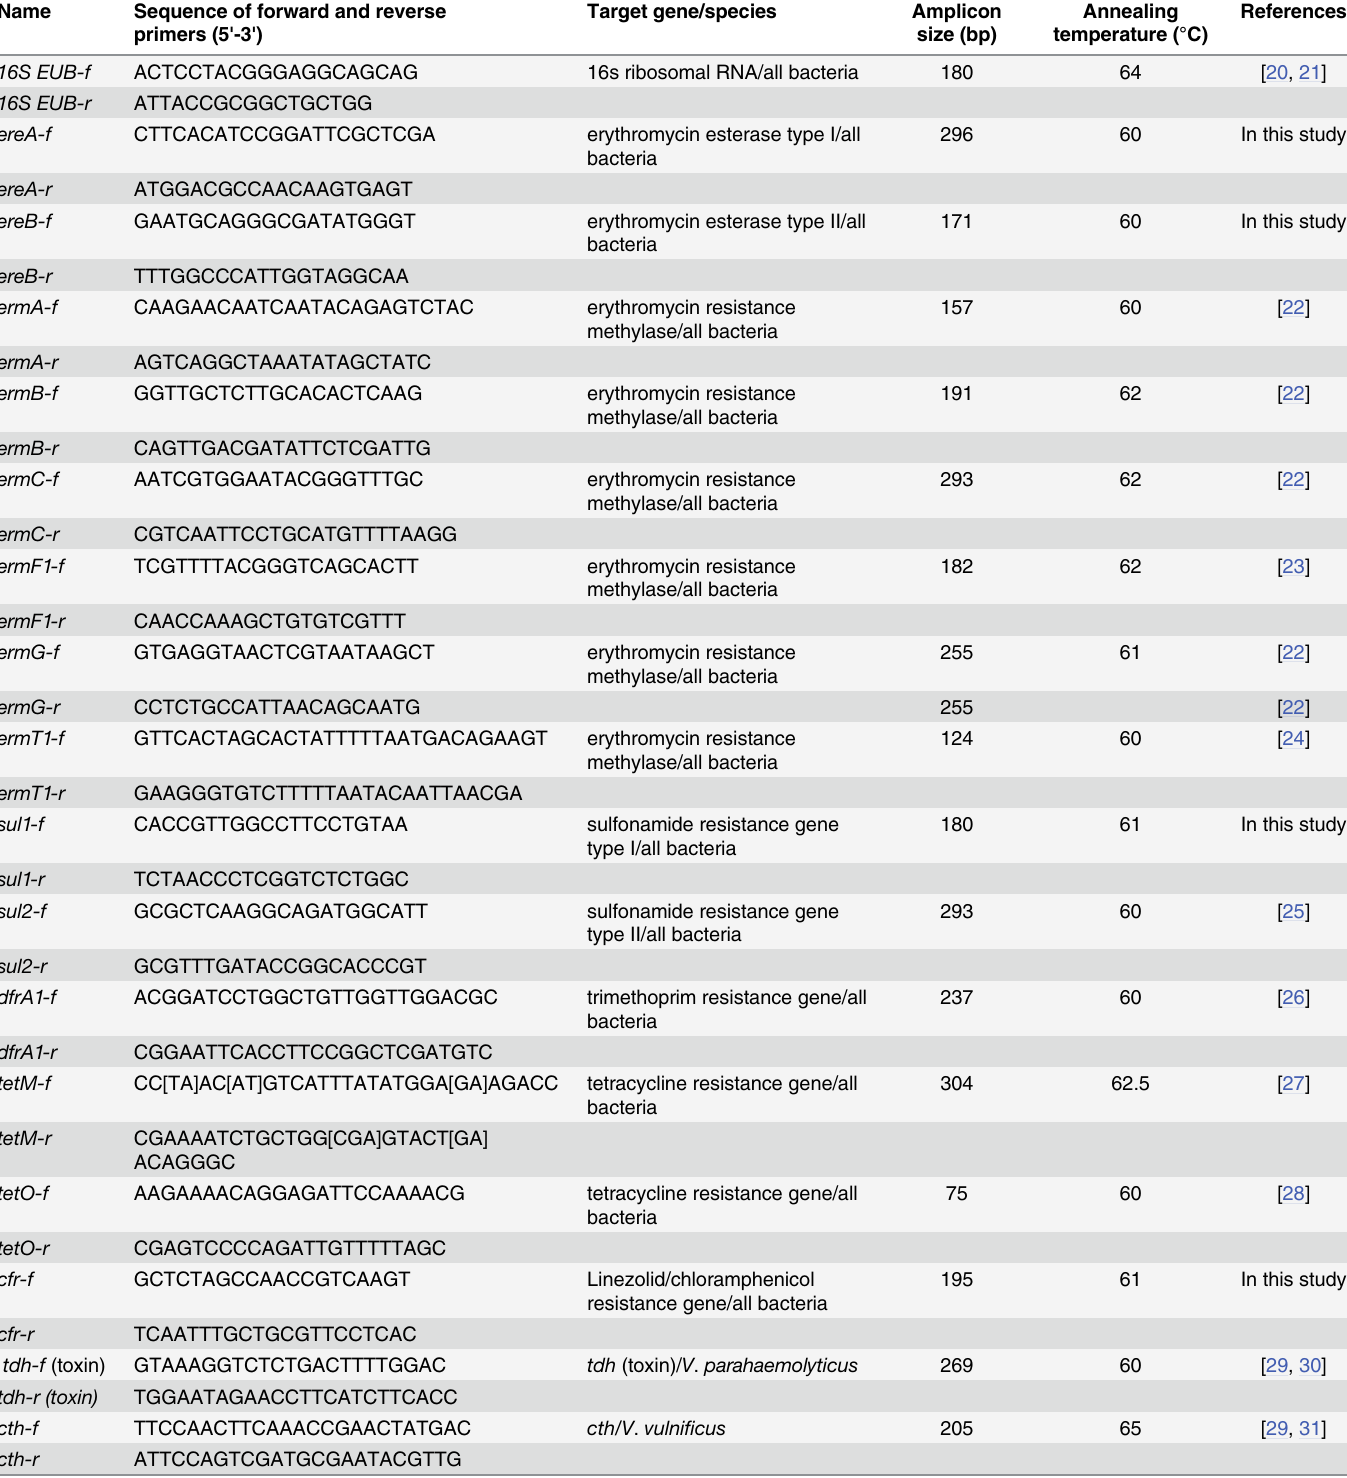
Table 1. Primer sets used in the detection of ARGs and indicator organisms in ballast and harbor water